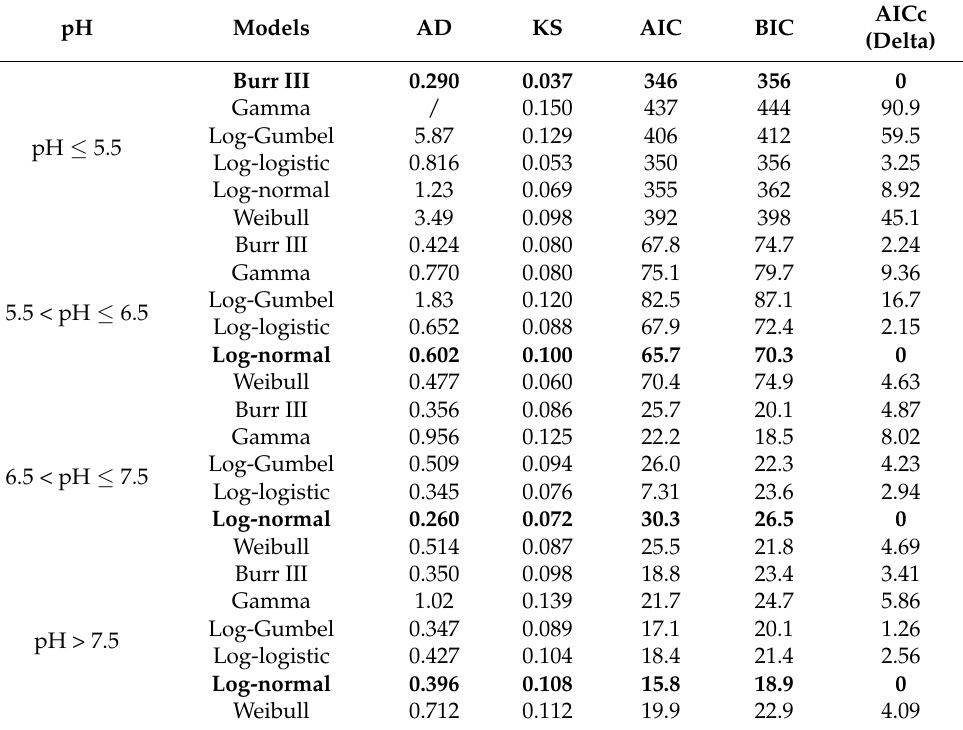
Figure 5. Relationships between the measured and predicted concentrations of Cd in rice grains. The red area represents the 95% prediction interval. red area represents the 95% prediction interval. Table 3. Goodness-of-fit of distribution models for soil–rice